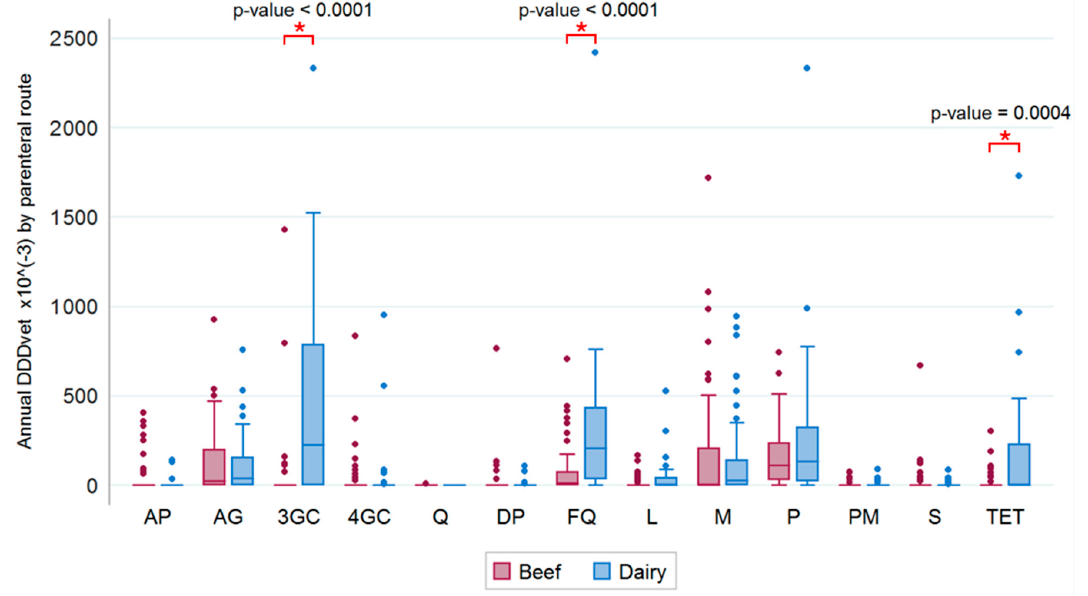
Figure 5. Annual consumption of antibiotics (DDD vet / year × 10 − 3 ) via the parenteral route per antimicrobial class on beef and dairy farms. (AP = amphenicols, AG = aminoglycosides, 3GC / 4GC = III / IV generation cephalosporins, Q = quinolones, DP = diaminopyrimidines (trimethoprim), FQ = fluoroquinolones, L = lincosamides, M = macrolides, P = penicillins, PM = polymyxins, S = sulfonamides, TET = tetracyclines).